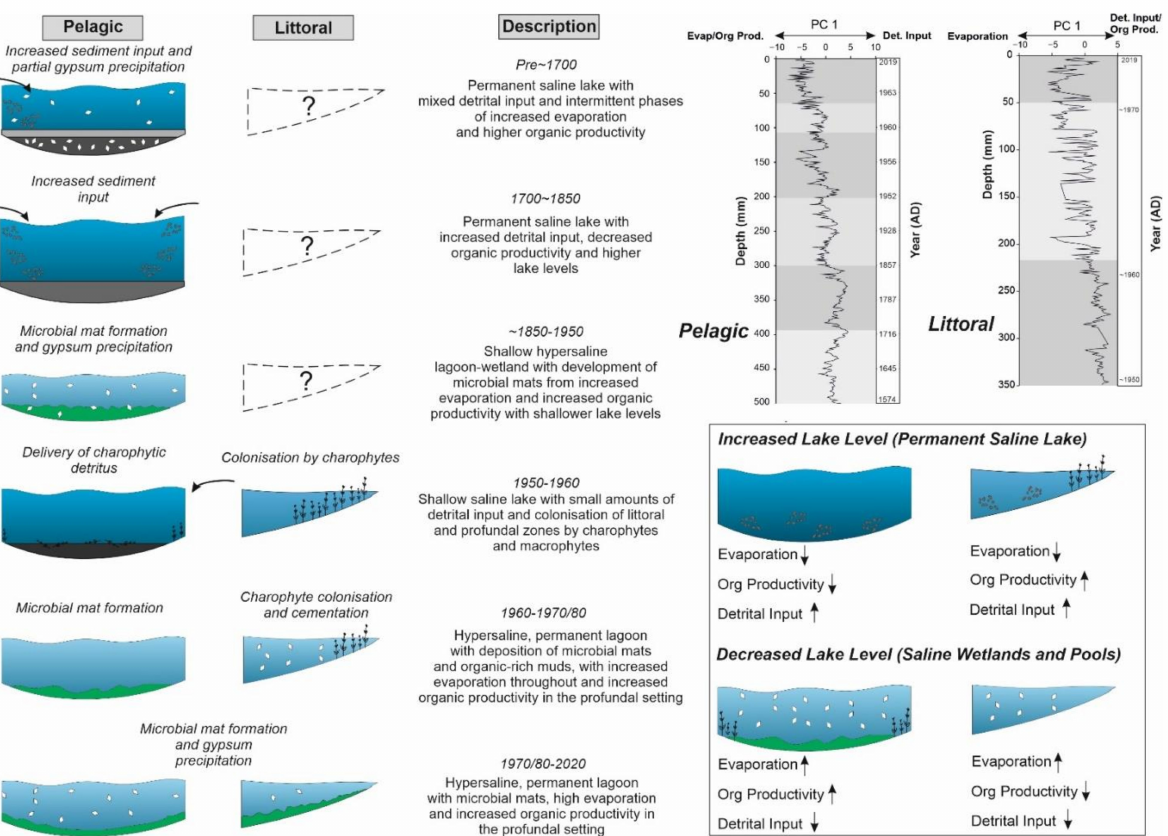
Figure 12. Palaeoenvironmental models constructed from the sedimentary and geochemical sequence from Lake Chiprana. The sequence, representing approximately the past ~300–400 years of environmental change, has been subdivided into six primary phases. Each phase represents largely different environmental conditions leading to the highly variable sedimentary and geochemical characteristics associated with the sequence. In addition, principal components associated with the profundal and littoral settings are presented. These components highlight the degree of key environmental processes occurring within Lake Chiprana and additionally illustrate the variability and intensity of such processes in the spatial domain. The effects of increasing and decreasing on lake levels upon the different environments are also